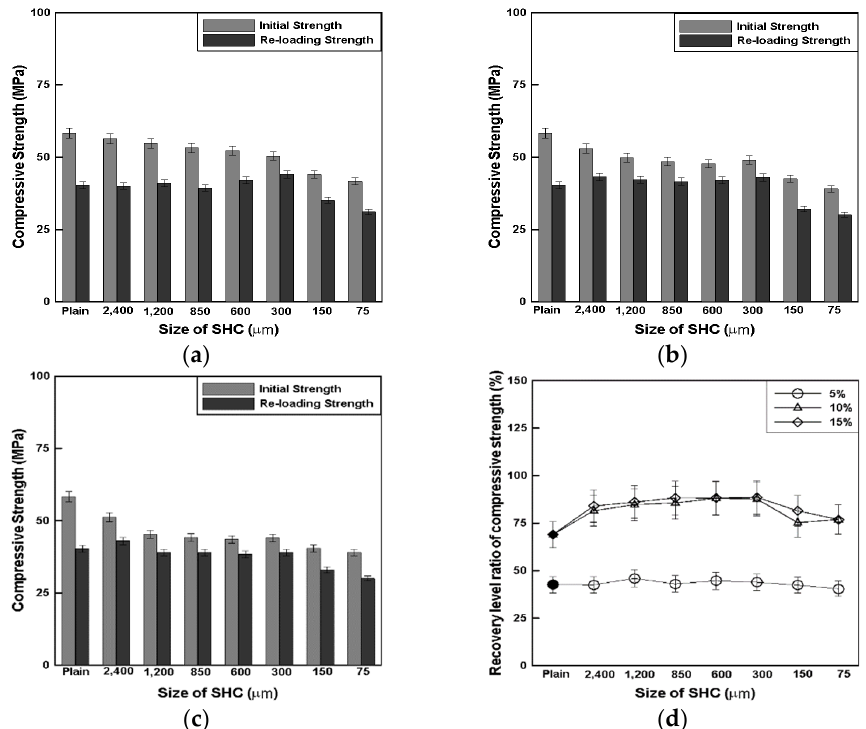
Figure 9. Re-loading test result of compressive strength: ( a ) SHC 5%, ( b ) SHC 10%, ( c ) SHC 15%, ( d ) recovery level.